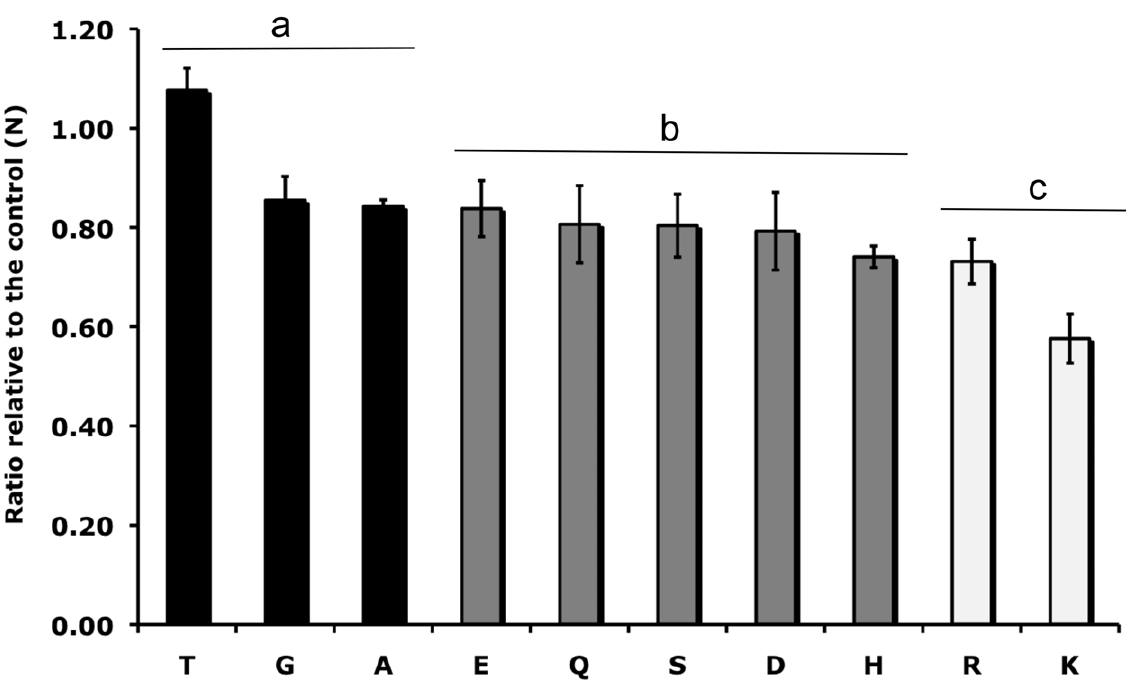
Figure 2. Inhibition of binding to DBP variants containing single amino acid substitutions at the 417 site. Sera raised against Sal I DBP (containing N417) was tested for its inhibitory efficacy against variant DBP forms with single amino acid changes created on a Sal I strain background using site-directed mutagenesis. Inhibition ratios were calculated by dividing the percentage inhibition against the variant DBP by the percentage inhibition against the Sal I control DBP. a DBP variants which were not significantly different from the Sal I (N) control (p . 0.05). b DBP variants which were significantly different from both N and K (p , 0.05). c DBP variants which were significantly different from N (p , 0.05), but not significantly different from K (p . 0.05). Statistical differences were calculated using a Dunn’s multiple comparisons t-test with a Bonferroni correction for multiple